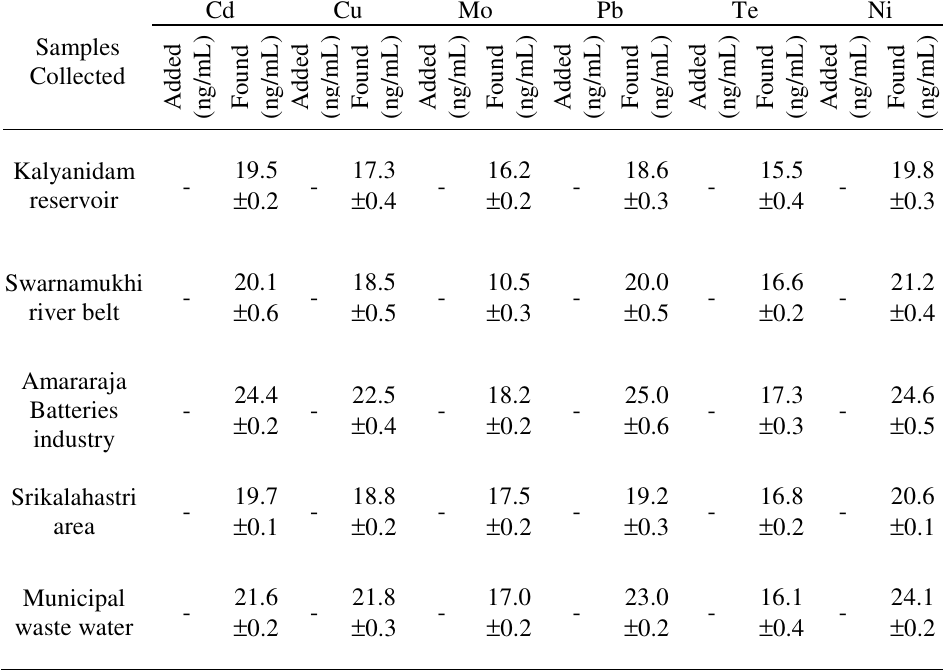
Table 2. Determination of trace elements in natural water samples around Tirupati town Cd